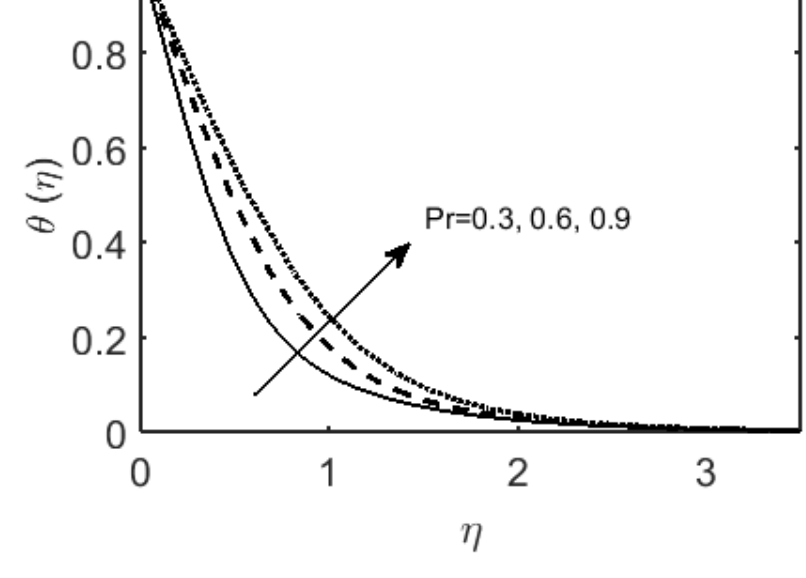
Figure 6. Impact of Pr on hotness.